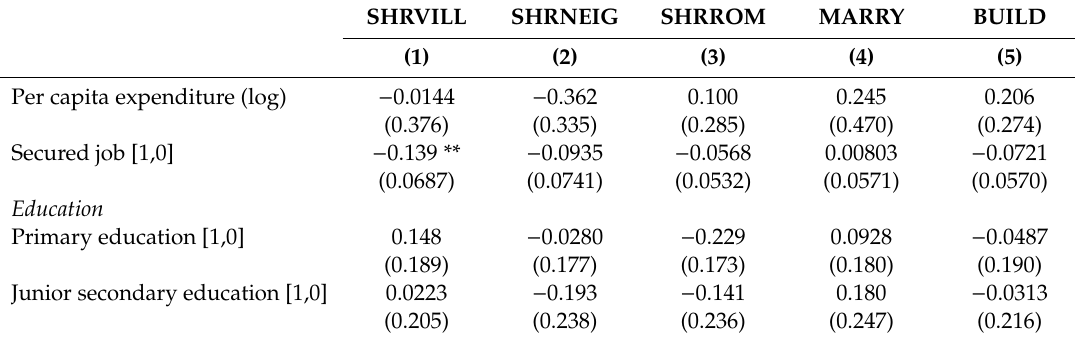
Table A5. Regression results (Fixed-e ff ect conditional logit Model), Income–Poverty